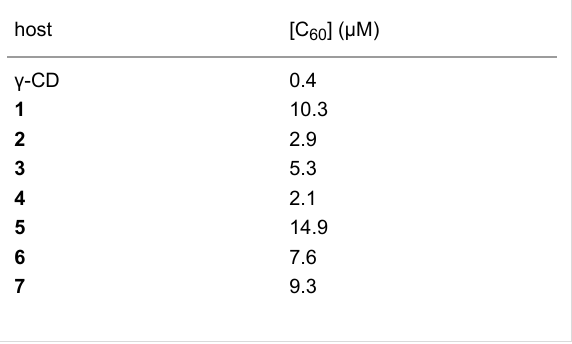
complexes with the aid of 60